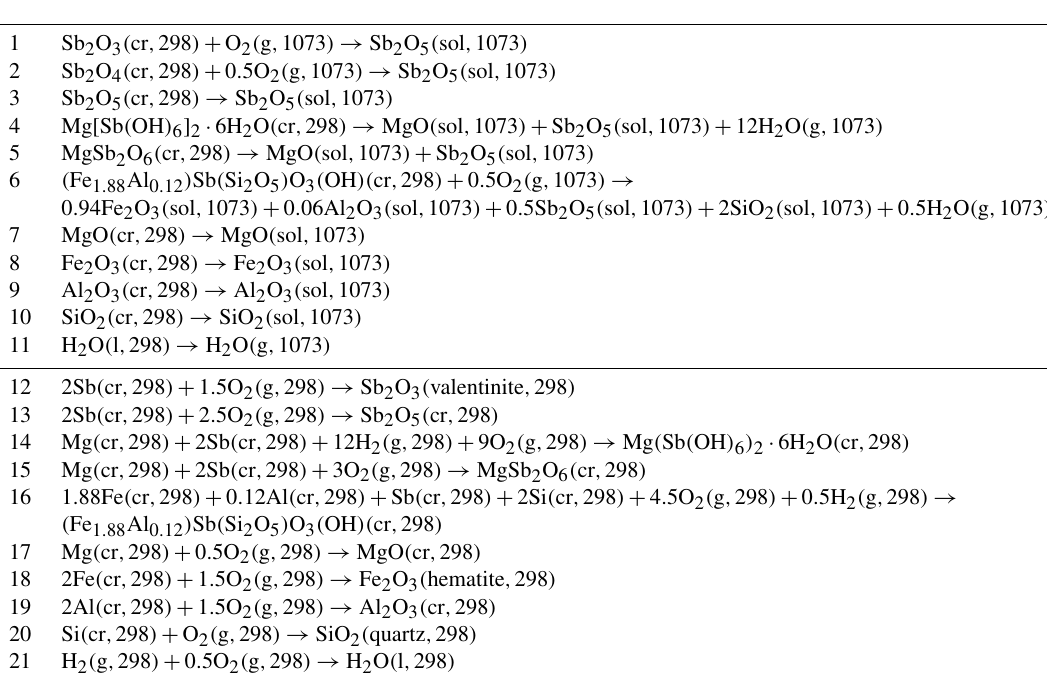
Table 3. Reactions considered in the thermochemical cycles used to calculate the enthalpies of selected reactions in the text and enthalpies of formation. cr: crystalline; l: liquid; g: gas; sol: solution in the molten calorimetric solvent. The numbers in parentheses indicate temperature in kelvin (K).